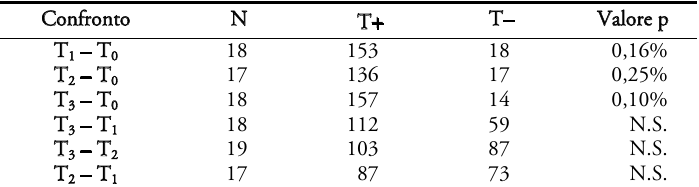
TABELLA 2 Risultati del test di Wilcoxon applicato ai